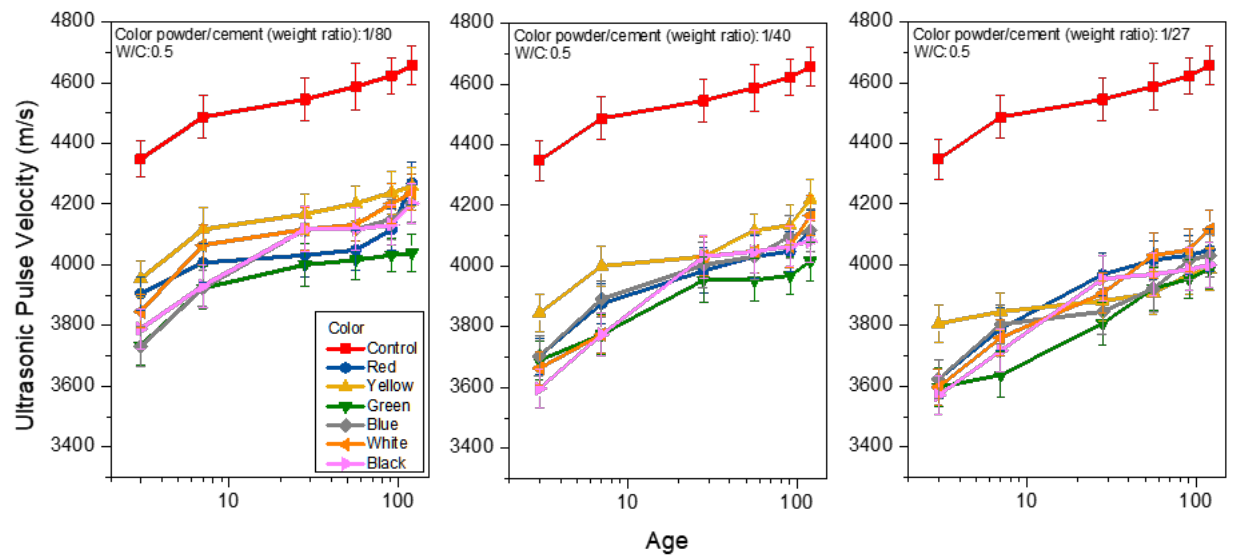
Figure 11. Ultrasonic pulse velocities of colored mortar with different proportions of inorganic color powder.